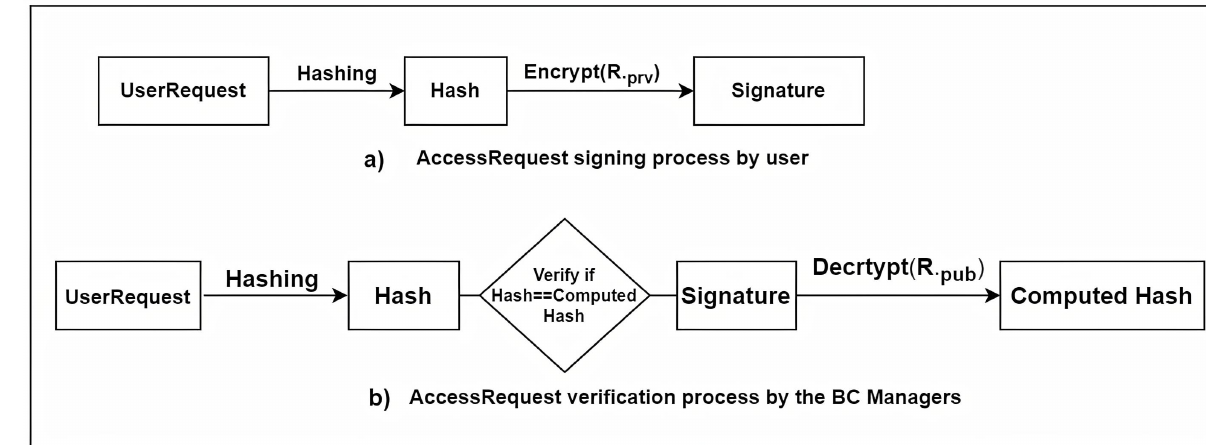
Figure 4. Signing and verification